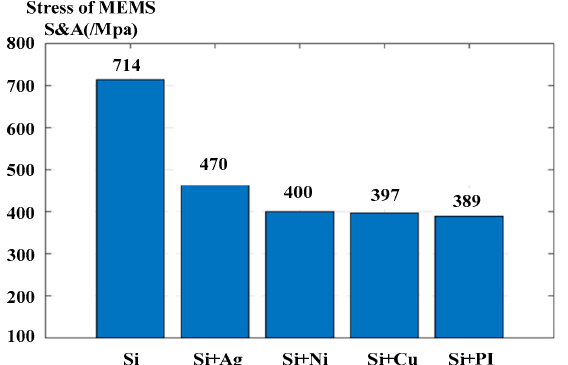
Figure 7. Maximum stress of the MEMS S&A device for various explosion suppression mechanism energy-absorbing materials.